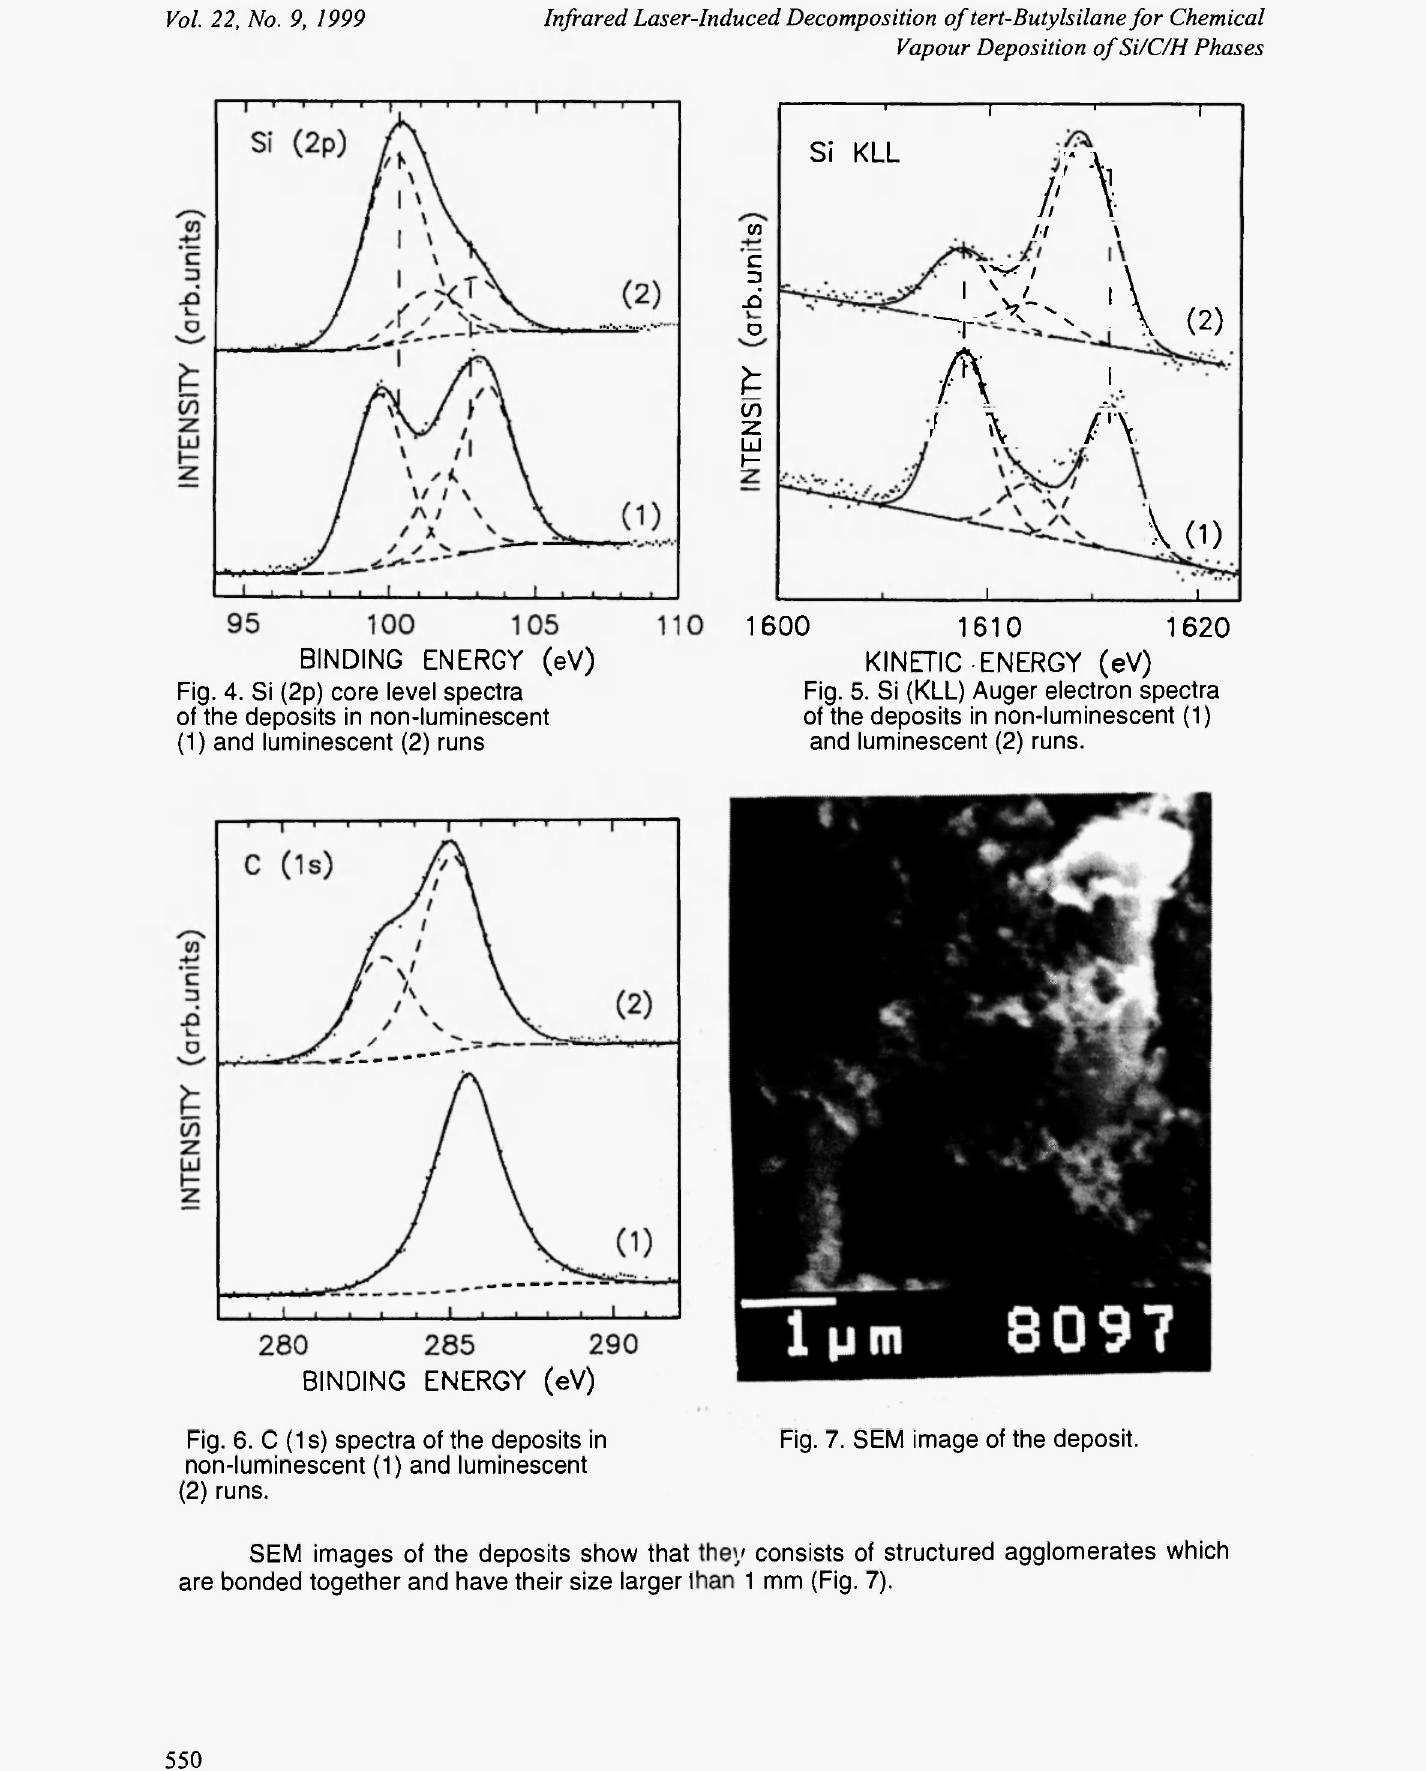
Fig. 6. C (1s) spectra of the deposits in non-luminescent (1) and luminescent (2) runs.